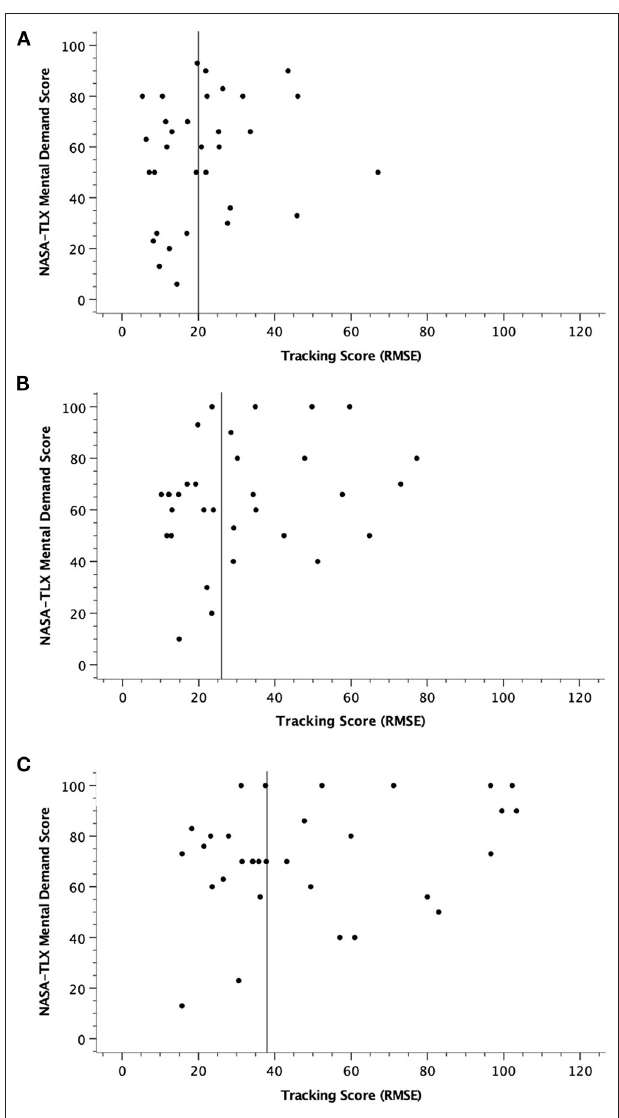
FIGURE 3 | Scatterplots of NASA-TLX Mental Demand scores and MAT tracking scores in single task (A) , dual-task (B) , and tri-task (C) tracking conditions.